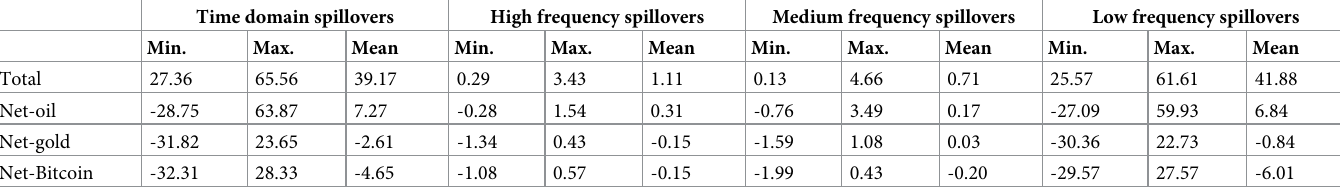
Table 4. The statistical results of time-frequency dynamics of volatility spillovers in crude oil, gold, and Bitcoin markets. Time domain